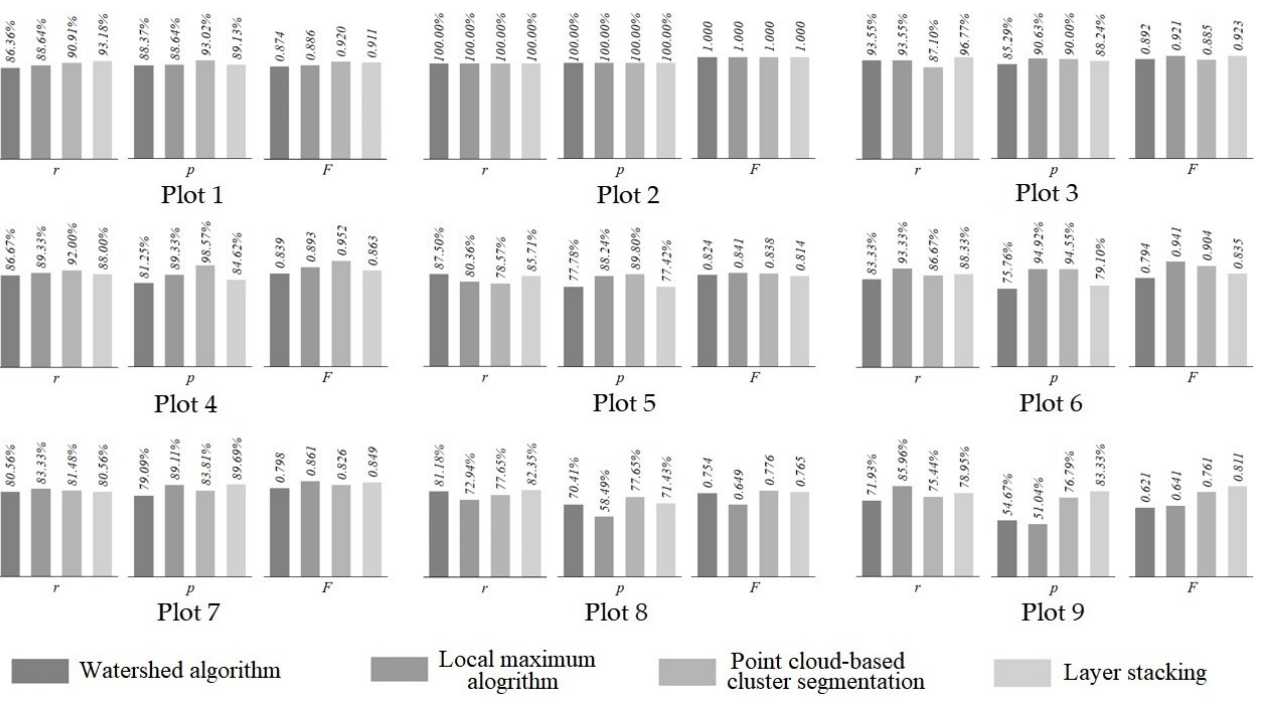
Figure 5. The accuracy of individual tree detection in nine plots: r is the detection rate, p is the accuracy rate, and F is the overall accuracy.